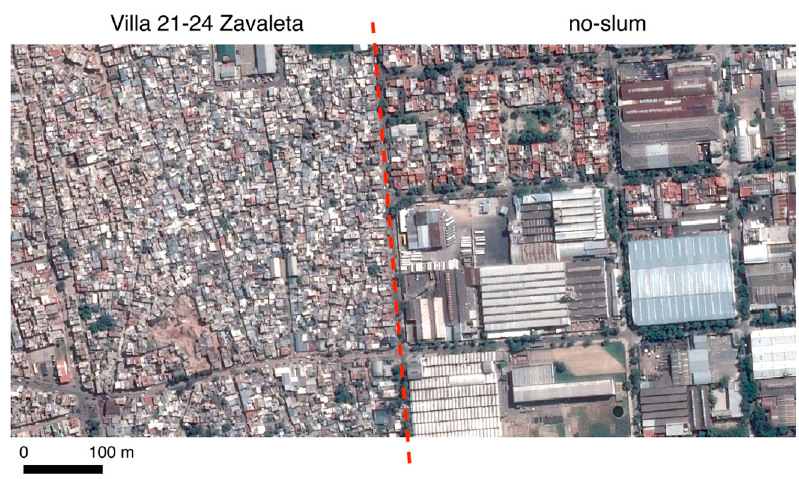
Figure 12. Slum sector in Buenos Aires (Villa Zavaleta) compared to the adjacent no-slum area. The red line indicates the slum boundary as mapped in [38].